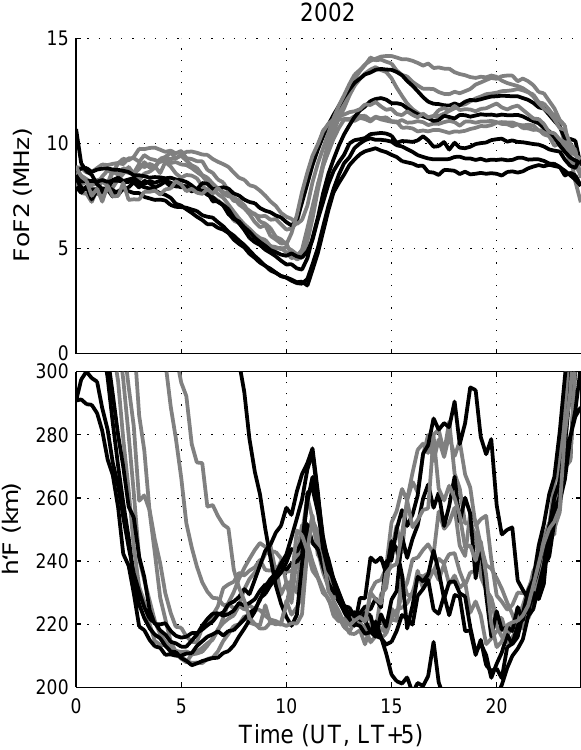
to illustrate the differences when a finite vertical drift is in- cluded.